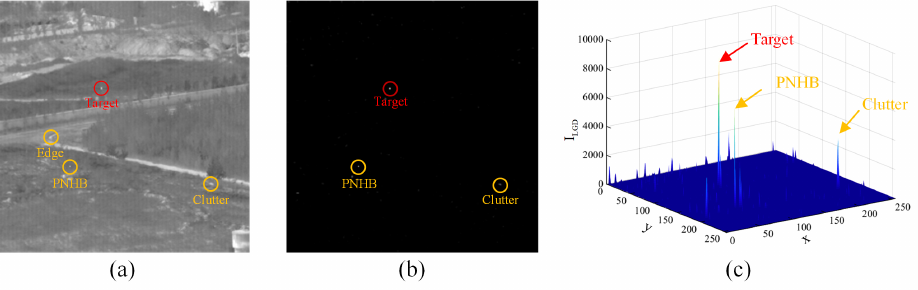
Figure 4. An example of LGD result. ( a ) The original infrared image. ( b ) The saliency map of LGD measure. ( c ) The 3D view of ( b